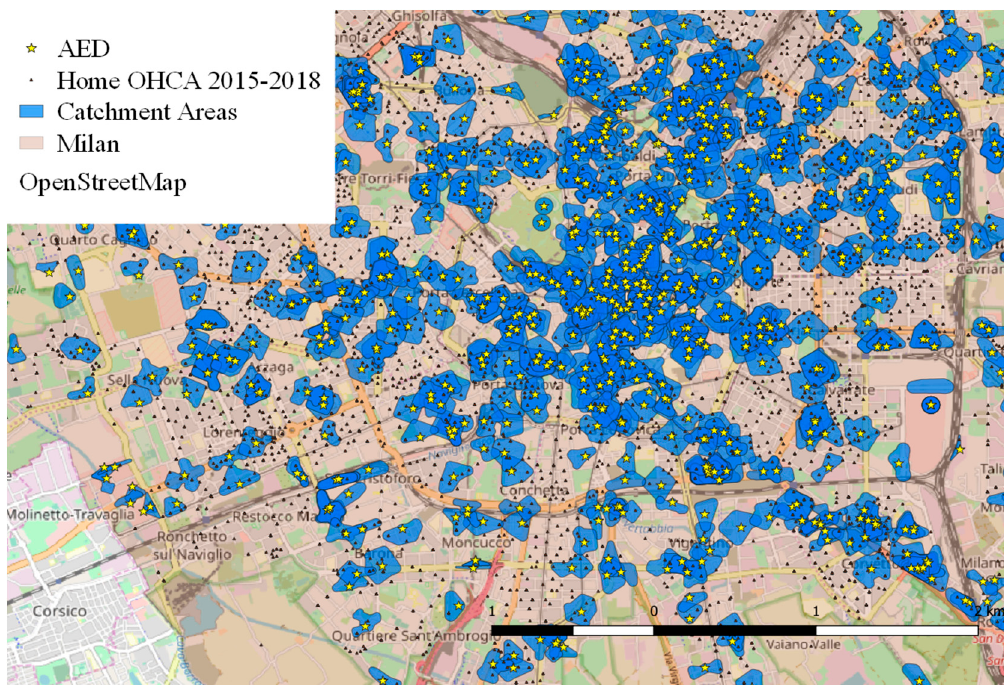
Figure 4. A zoomed portion of the city of Milan, with the position of each Automated External Defibrillator (AED, yellow stars) and its realistic catchment area, and the position of each residential Out-of-Hospital Cardiac Arrest (OHCA) in the period 2015–2018 (black dot).